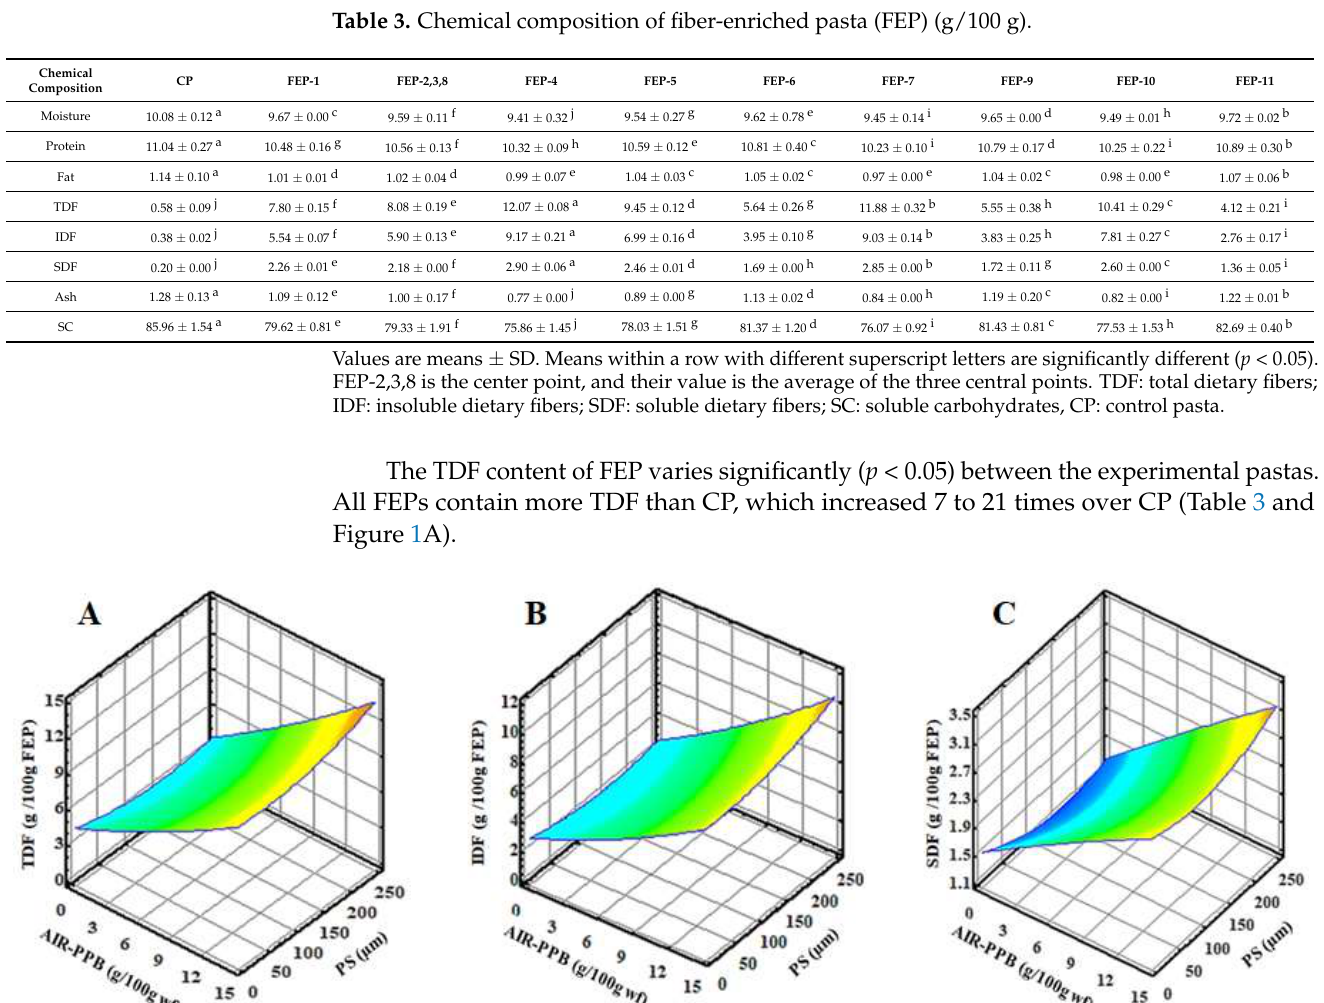
Table 3. Chemical composition of fiber-enriched pasta (FEP) (g/100 g).